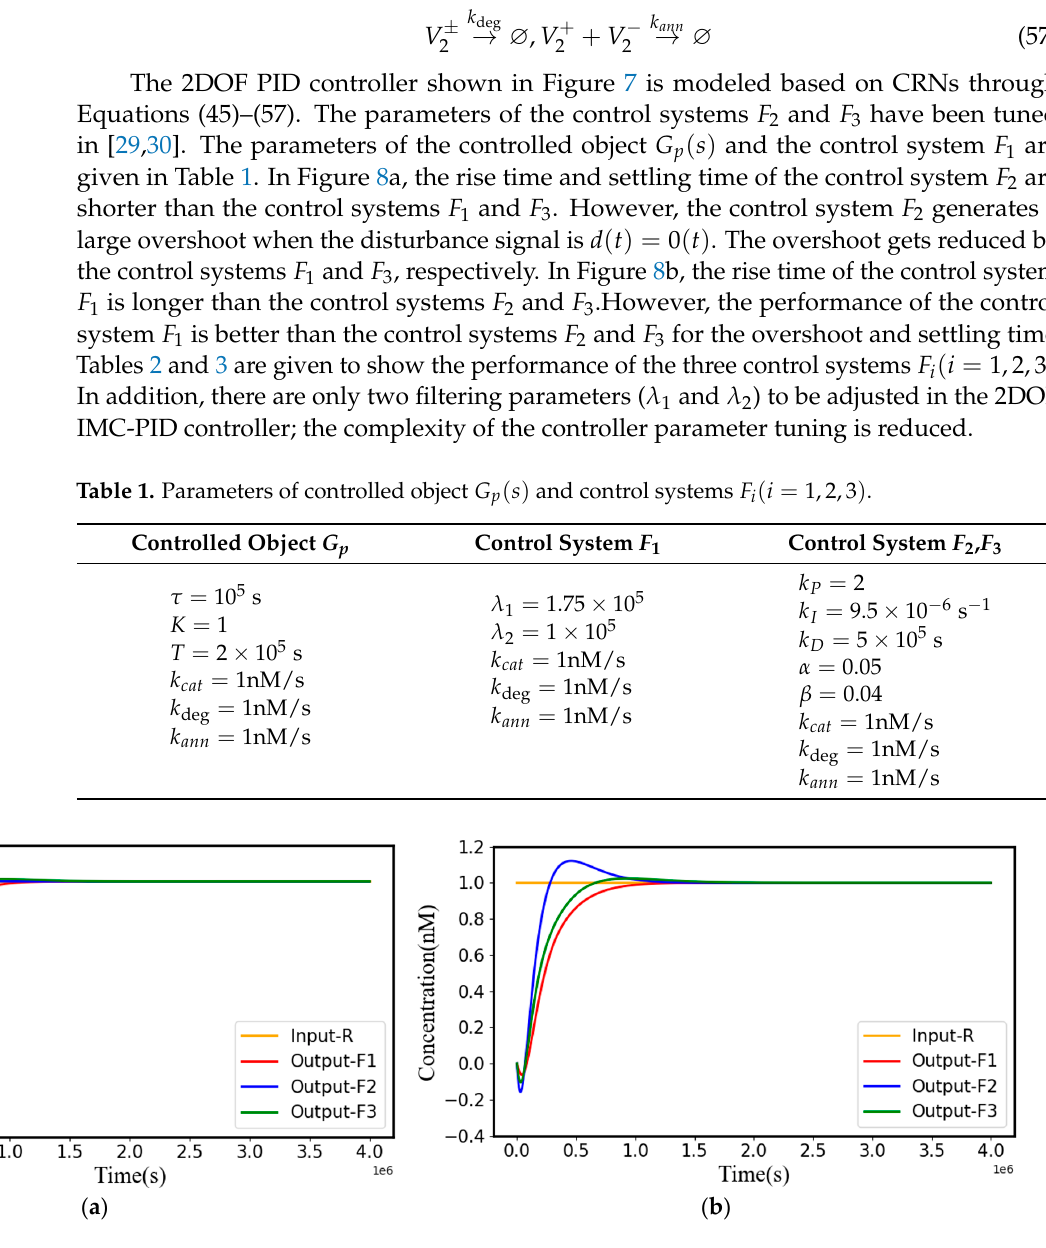
Figure 8. Output response curves of three control systems F i ( i = 1,2,3 ) : ( a ) when there is no disturbance input of systems; ( b ) when the disturbance signal of systems is d ( t ) = 1 ( t ) . Table 2. Performance of three control systems without disturbance Table 1. Parameters of controlled object